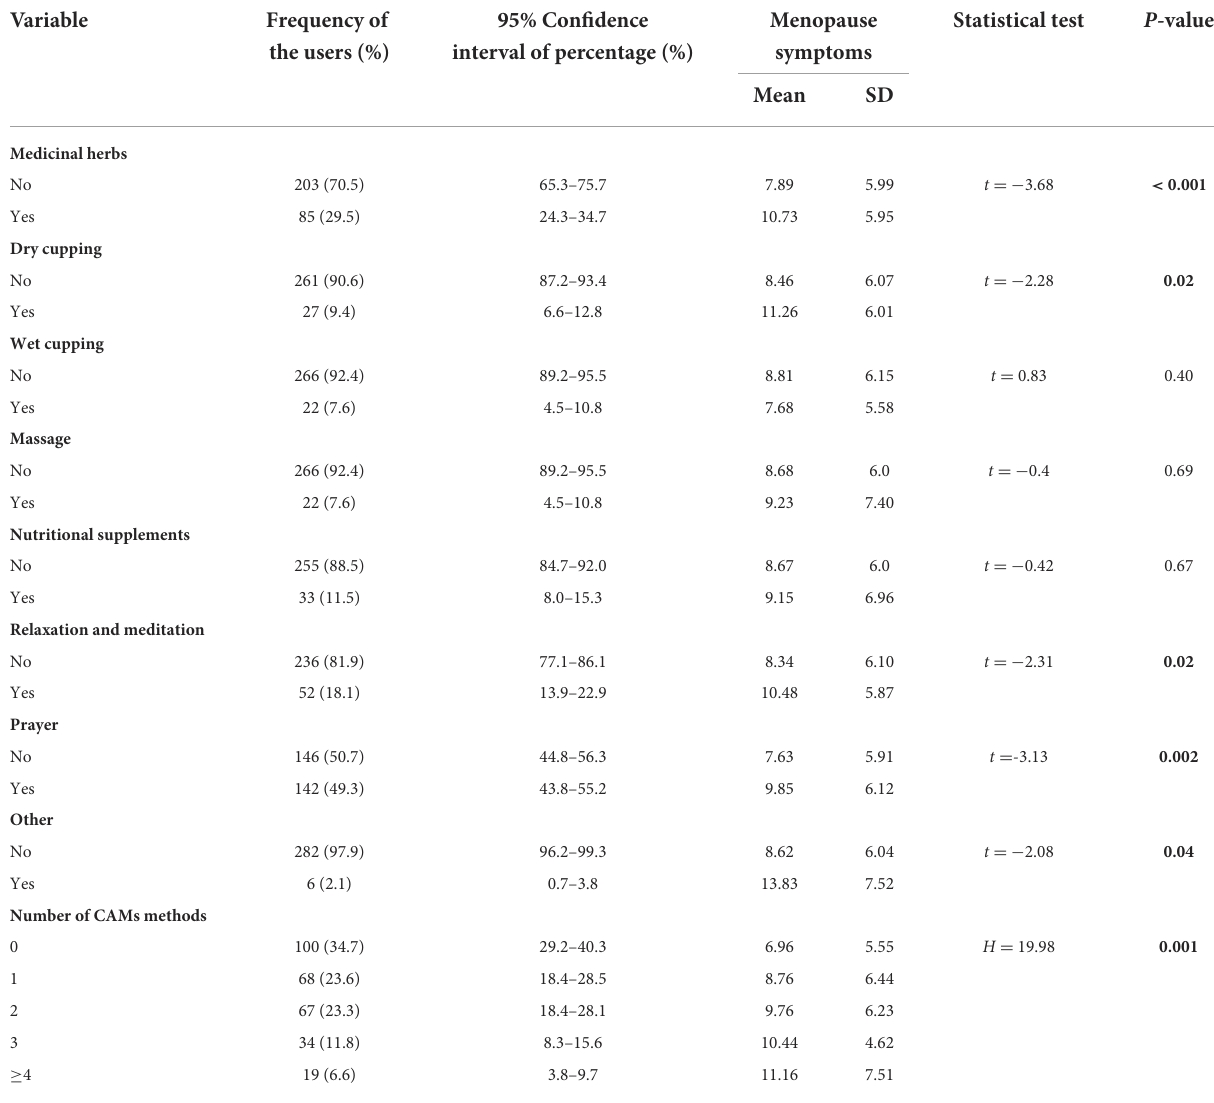
TABLE 3 The use of different methods of CAMs and its association with menopause symptoms.